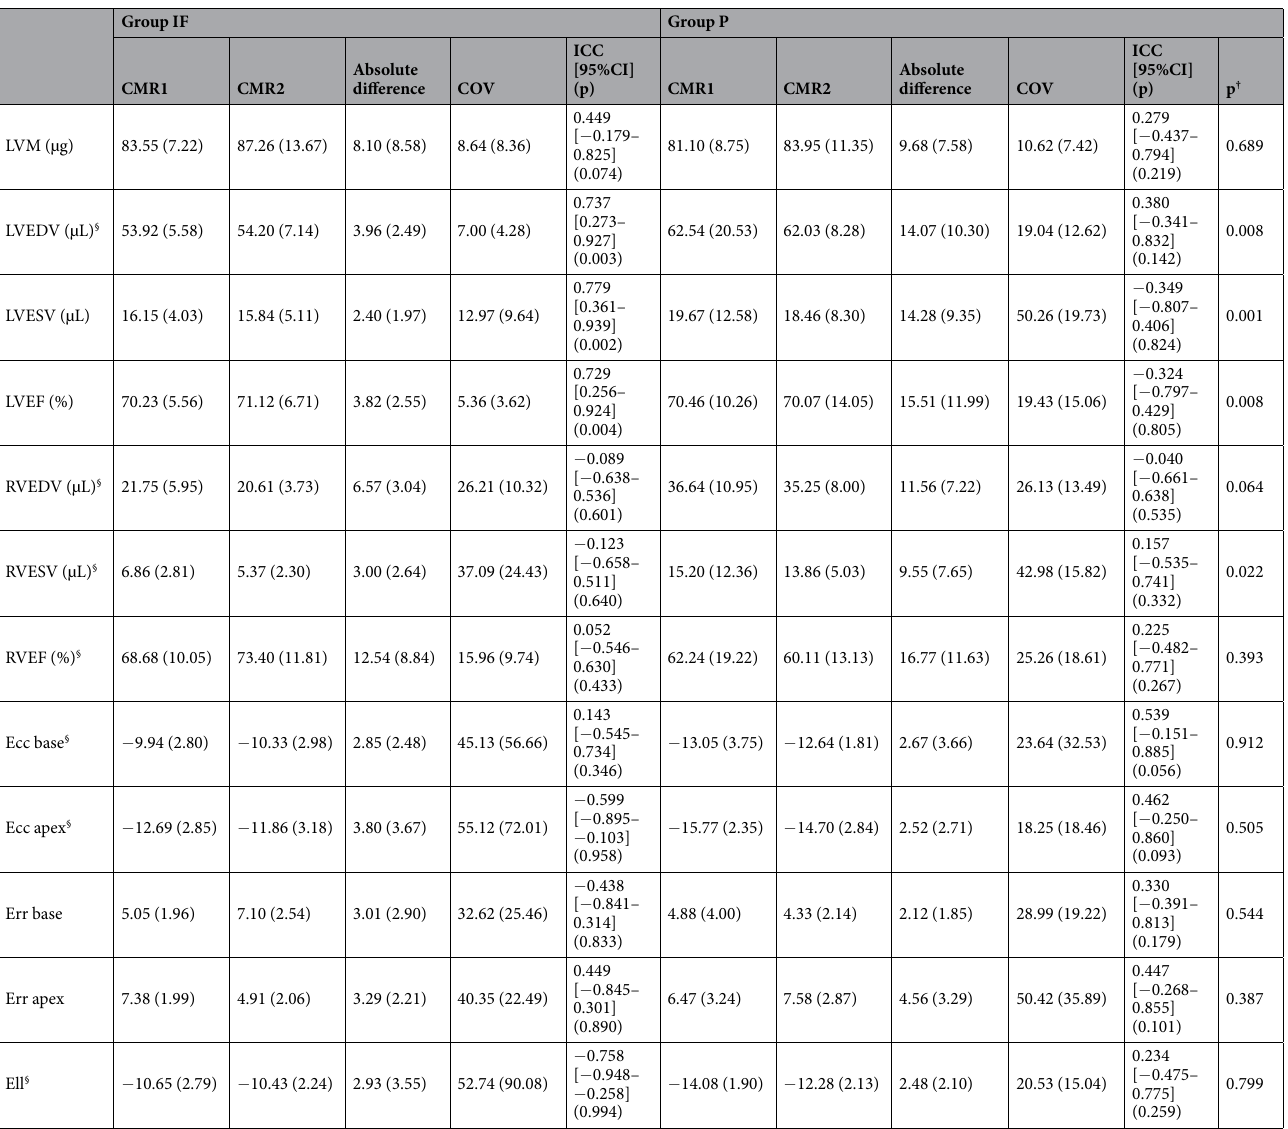
Table 2. Inter-study reproducibility as evaluated by the absolute difference, coefficient of variation (COV) (expressed in %) and interclass correlation (ICC) between results from the first (CMR1) and second (CMR2) cardiac magnetic resonance exams, during isoflurane (IF) and pentobarbital (P) anesthesia. Data are the mean (SD) except for ICC [95% interval confidence] (p). † Comparison of inter-study COV between groups IF and P. § Indicates CMR parameters that are different (p < 0.05) between groups IF and P (pooled data from CMR1 and